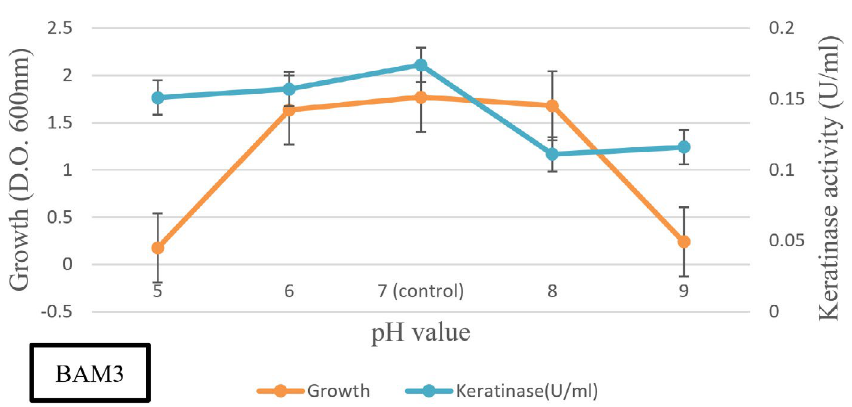
Fig. 5. The effect of pH on the production of keratinase by isolate BAM3